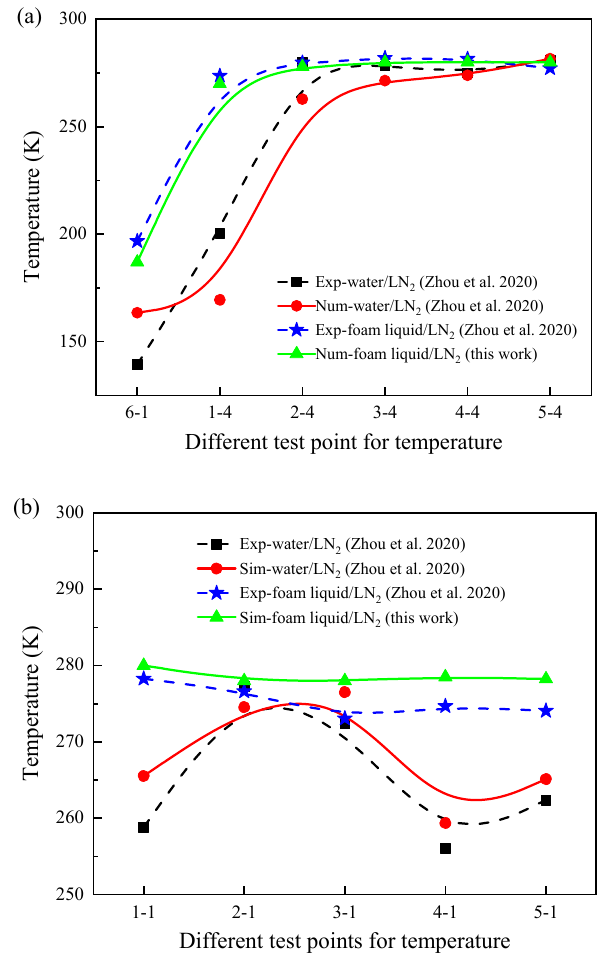
Figure 2. The results of model validation ( a , b ) [21].